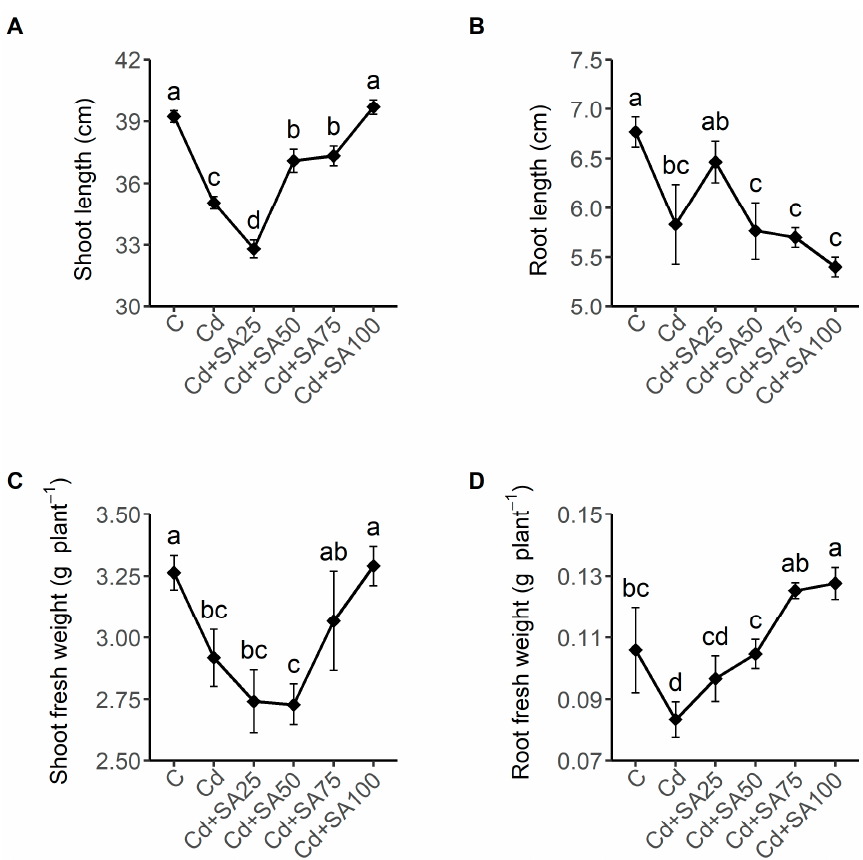
Figure 1. Effect of salicylic acid of different concentrations on the shoot length ( A ), root length ( B ), shoot fresh weight ( C ), and root fresh weight ( D ) of Tartary buckwheat cultivated in soil with Cd contamination. C denotes the control plant group without any treatment cultivated in the uncontaminated soil. Cd denotes the group of plants cultivated in the soil with 2.0 mg kg − 1 Cd contamination without SA treatment. Cd + SA25, Cd + SA50, Cd + SA75, and Cd + SA100 denote the plant groups cultivated in the soil with 2.0 mg kg − 1 Cd contamination treated with 25, 50, 75, and 100 µ mol L − 1 salicylic acid, respectively. Different lowercase letters denote significant differences between the treatment groups ( p < 0.05).